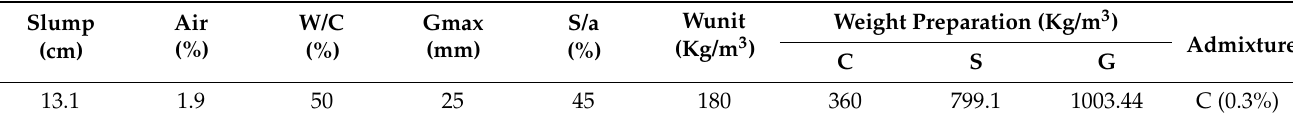
Table 11. Concrete